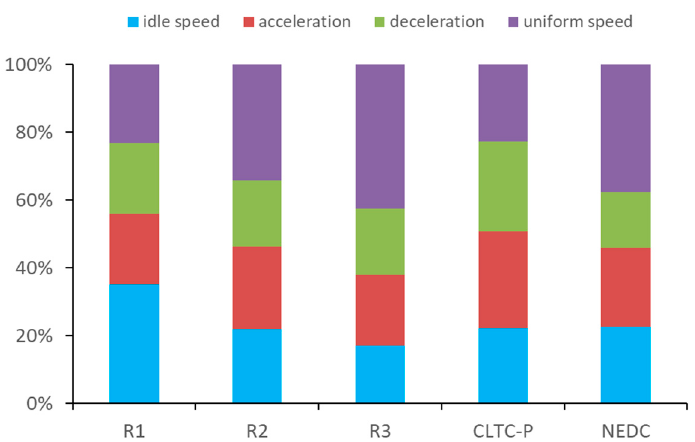
Figure 2. Comparison of conditions of each route.